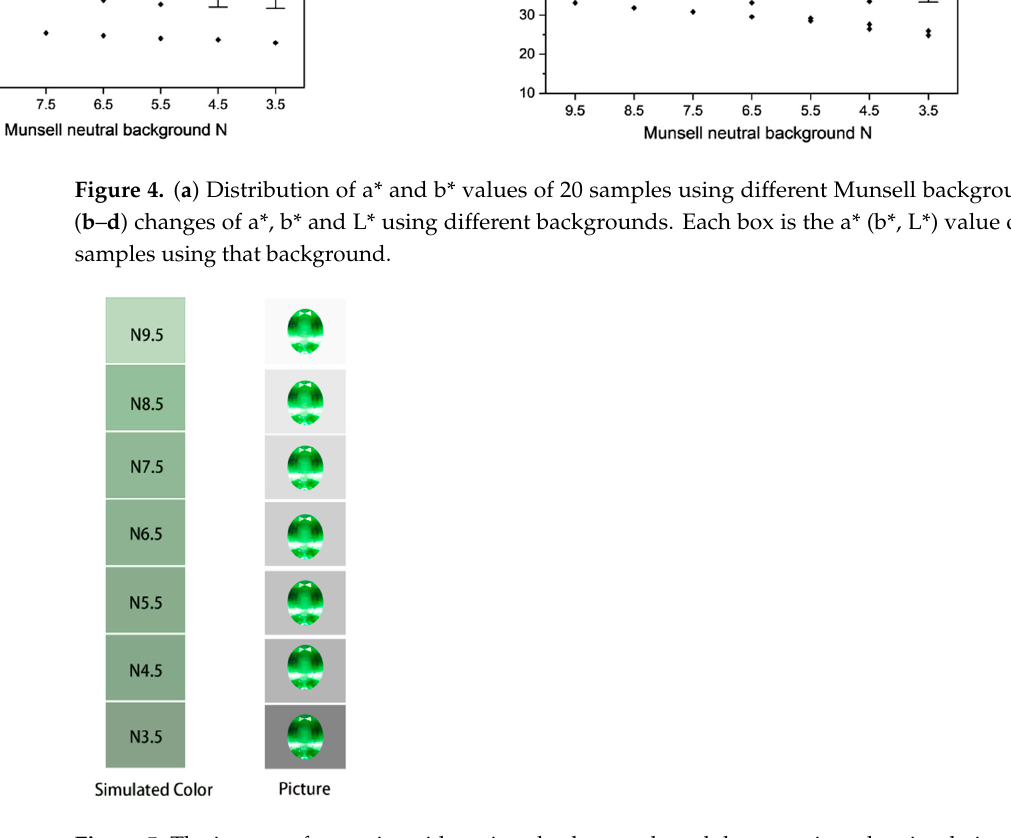
Figure 5. The images of tsavorite with various backgrounds and the tsavorite color simulation. Tsavorite’s chroma increases as the background’s gray scales decrease, and at the same time, the range of a* and b* widens, suggesting that the tsavorite’s colors scatter as the background gets brighter. Therefore, N9.5 is the best background for tsavorite color grading.